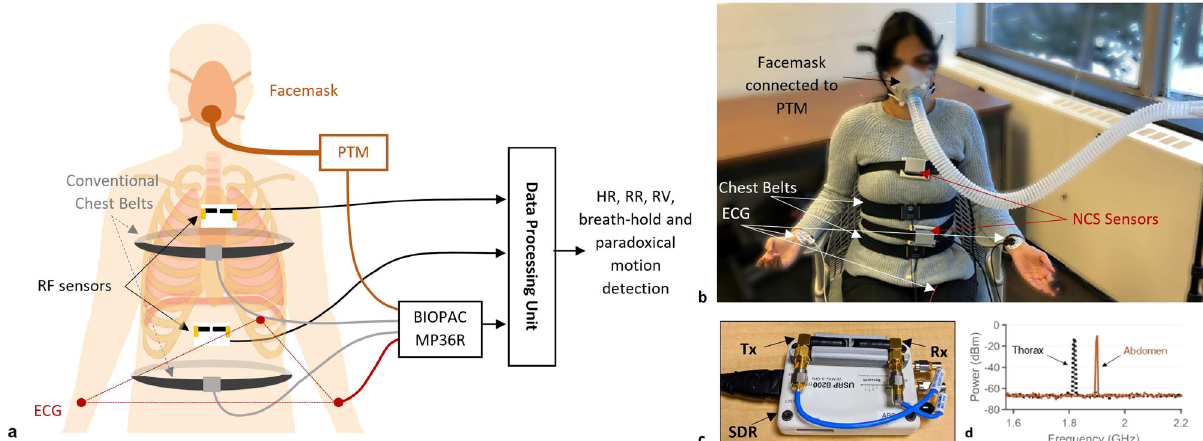
Fig. 1 The experimental system. a Schematics of NCS and BIOPAC sensors and data fl ow. b Experimental setup with the participant wearing NCS and BIOPAC sensors in the sitting posture. The photo was taken and published with the written informed consent of the subject. c The NCS sensor consisting of SDR as well as the Tx and Rx antennas in a 3D-printed package. d Spectrogram of thorax and abdomen NCS sensors at their respective carrier frequencies of 1.82 GHz ( − 12.84 dBm) and 1.9 GHz ( − 10.42